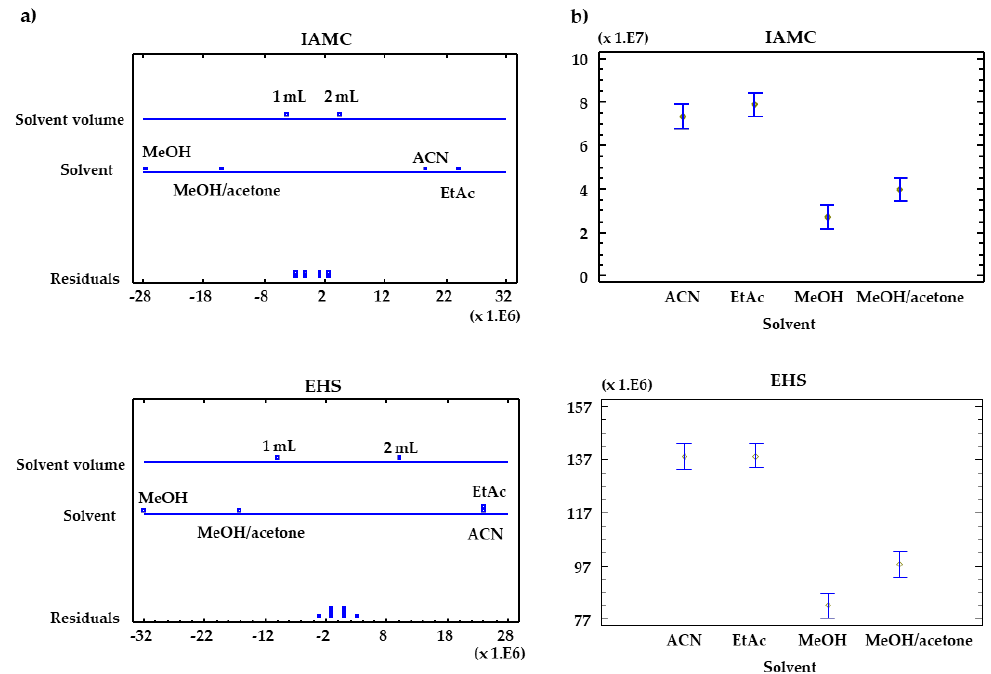
Figure 3. ( a , b ) ANOVA plots showing the main e ff ects for isoamyl-4-methoxycinnamate (IAMC) and ethylhexylsalicylate (EHS).